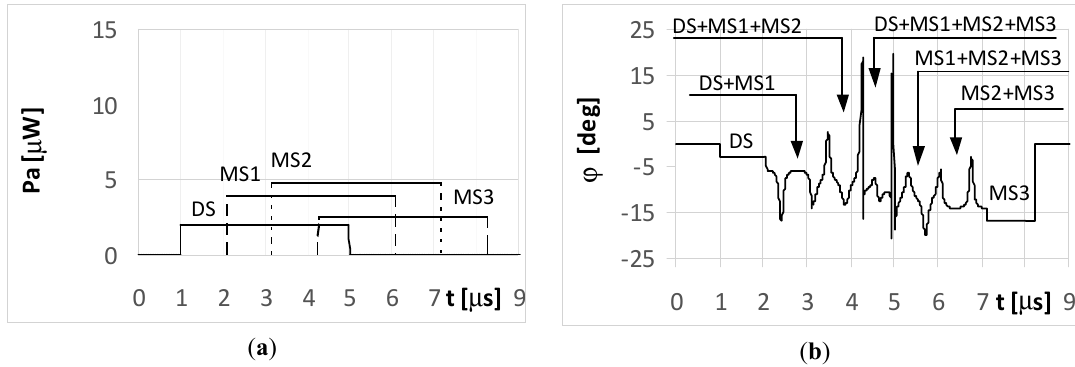
Figure 13. Envelopes of the direct signal (DS) and multipath signals (MS1, MS2, MS3) reflected from the ground, overlapping in time, and reaching UAV2 (shown in Figure 1) ( a ), and temporary angle of arrival ϕ estimated from the received resultant signal ( b ), (radar transmits LFM-type long pulsed signal with duration t i = 4 µ s , initial phases Φ 0D = Φ 01 = Φ 02 = Φ 03 = 0 ◦ , and deviation ∆ f = 5 MHz; AOA was estimated using the monopulse phase method from the DF device installed on UAV2 ).